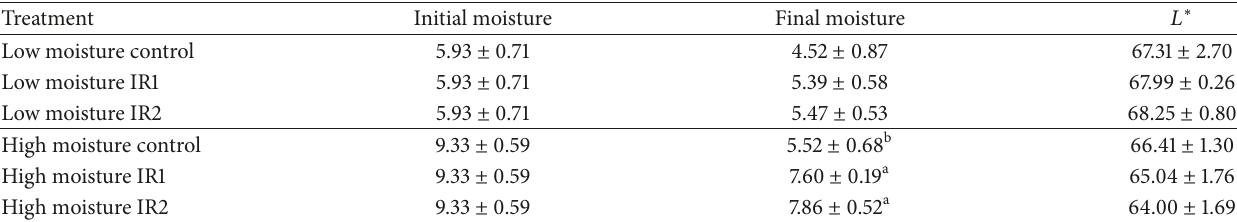
Table 3: Mean moisture content (% wet weight basis; before and after blanching) and lightness values (CIE 𝐿 ∗ ; after blanching) of peanuts for the various